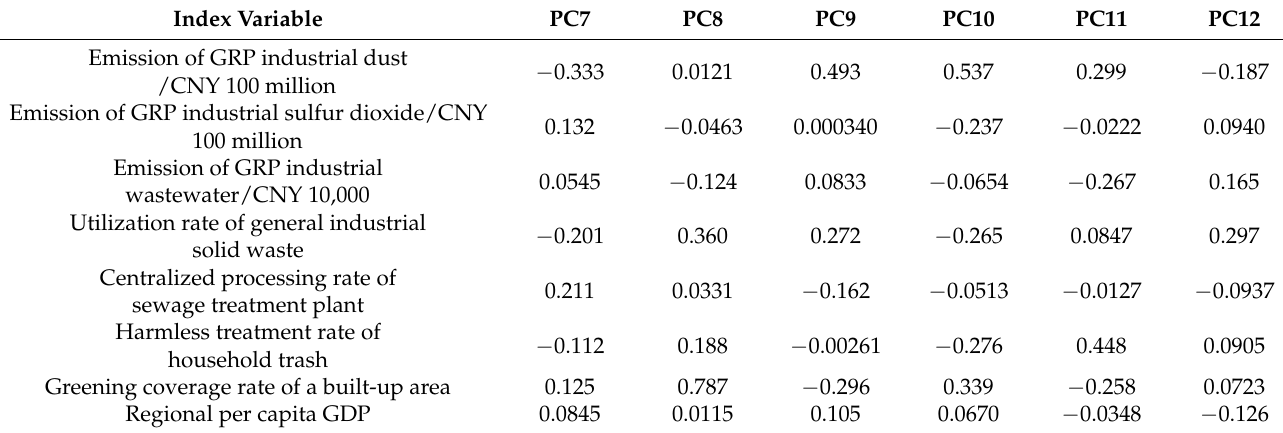
Table 8. Principal component